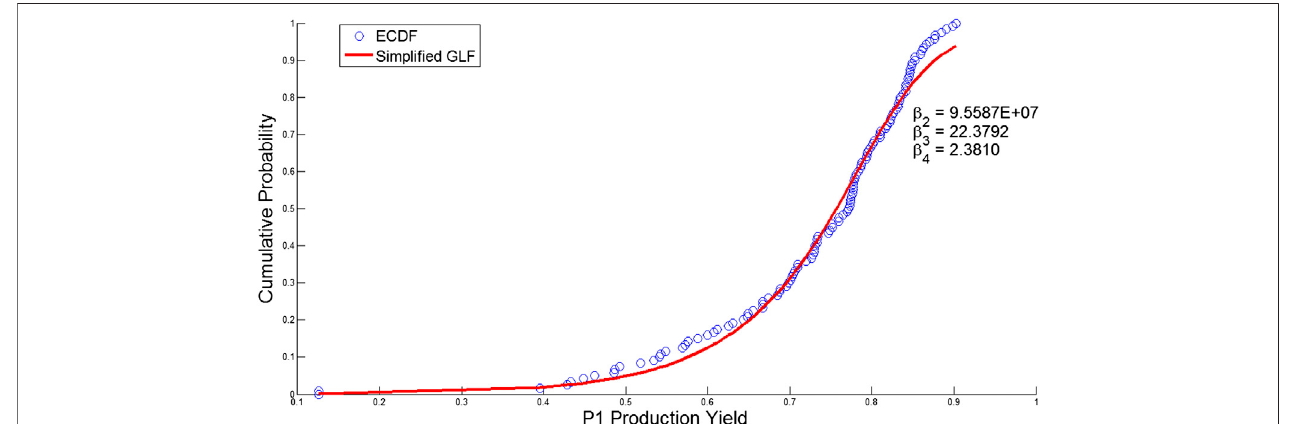
FIGURE 12 | Distribution of the historical data for the production yield of facility P1 (Calfa et al., 2014).